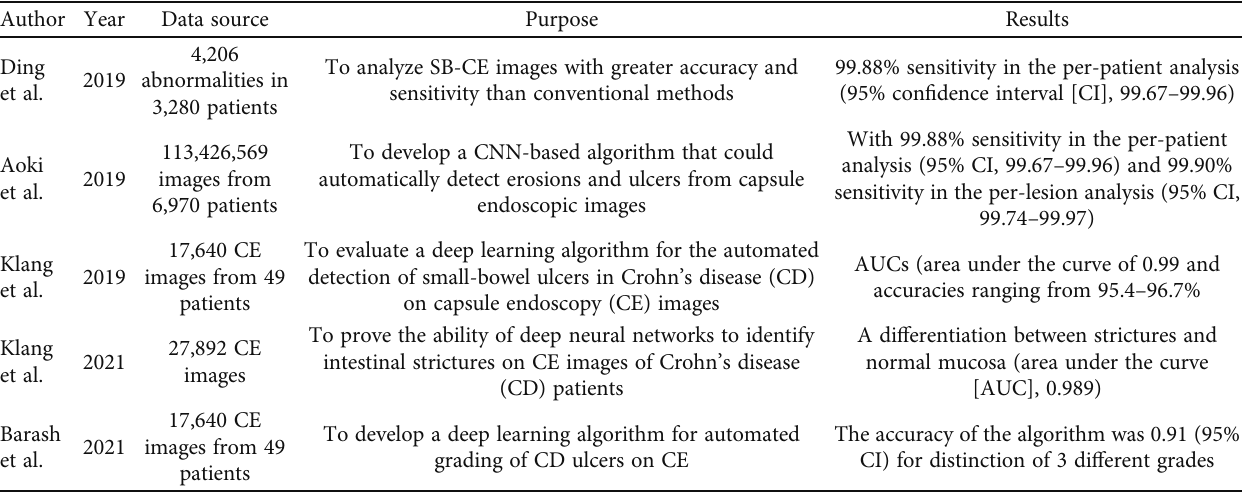
Table 2: Endoscopic AI applications in diagnosing